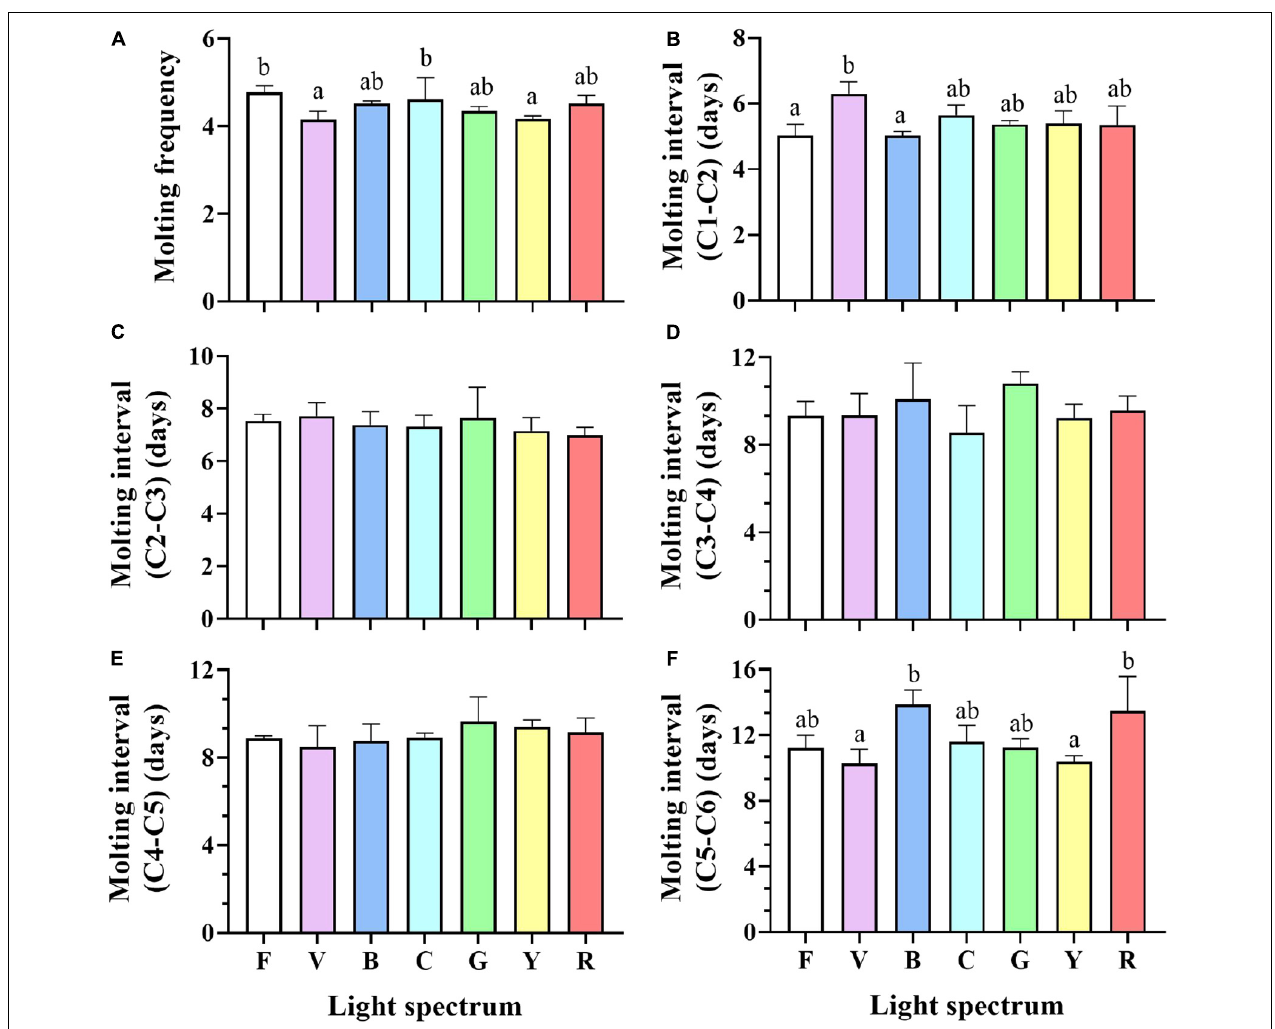
FIGURE 4 | Molting frequency (A) , Molting interval (C1-C2) (B) , Molting interval (C2-C3) (C) , Molting interval (C3-C4) (D) , Molting interval (C4-C5) (E) and Molting interval (C5-C6) (F) of S. paramamosain reared under the different spectra. Values are expressed as means ± SD ( n = 3, all survival crab per replicate). F, Full spectrum; V, Violet; B, Blue; C, Cyan; G, Green; Y, Yellow; R, Red. Different superscripts denote significant differences between treatments ( P <